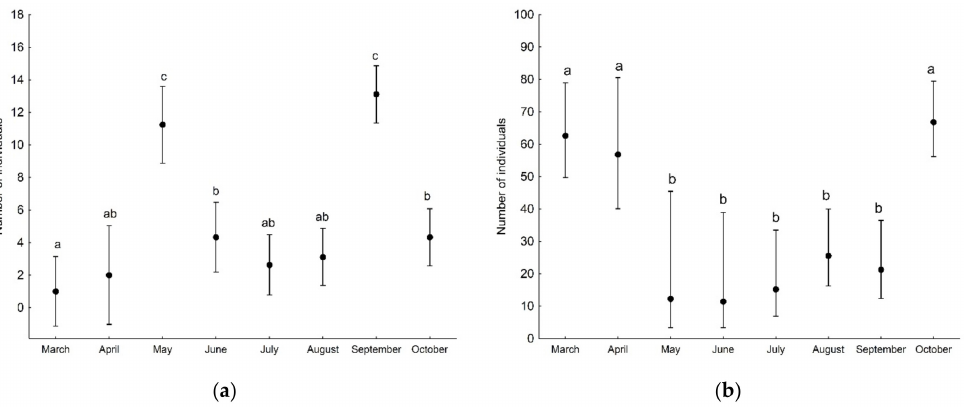
Figure 7. The number of adult ( a ) and juvenile ( b ) spider individuals (mean with 95% confidence limits) recorded on tree trunks in particular sampling months. Different letters indicate significant differences between sampling